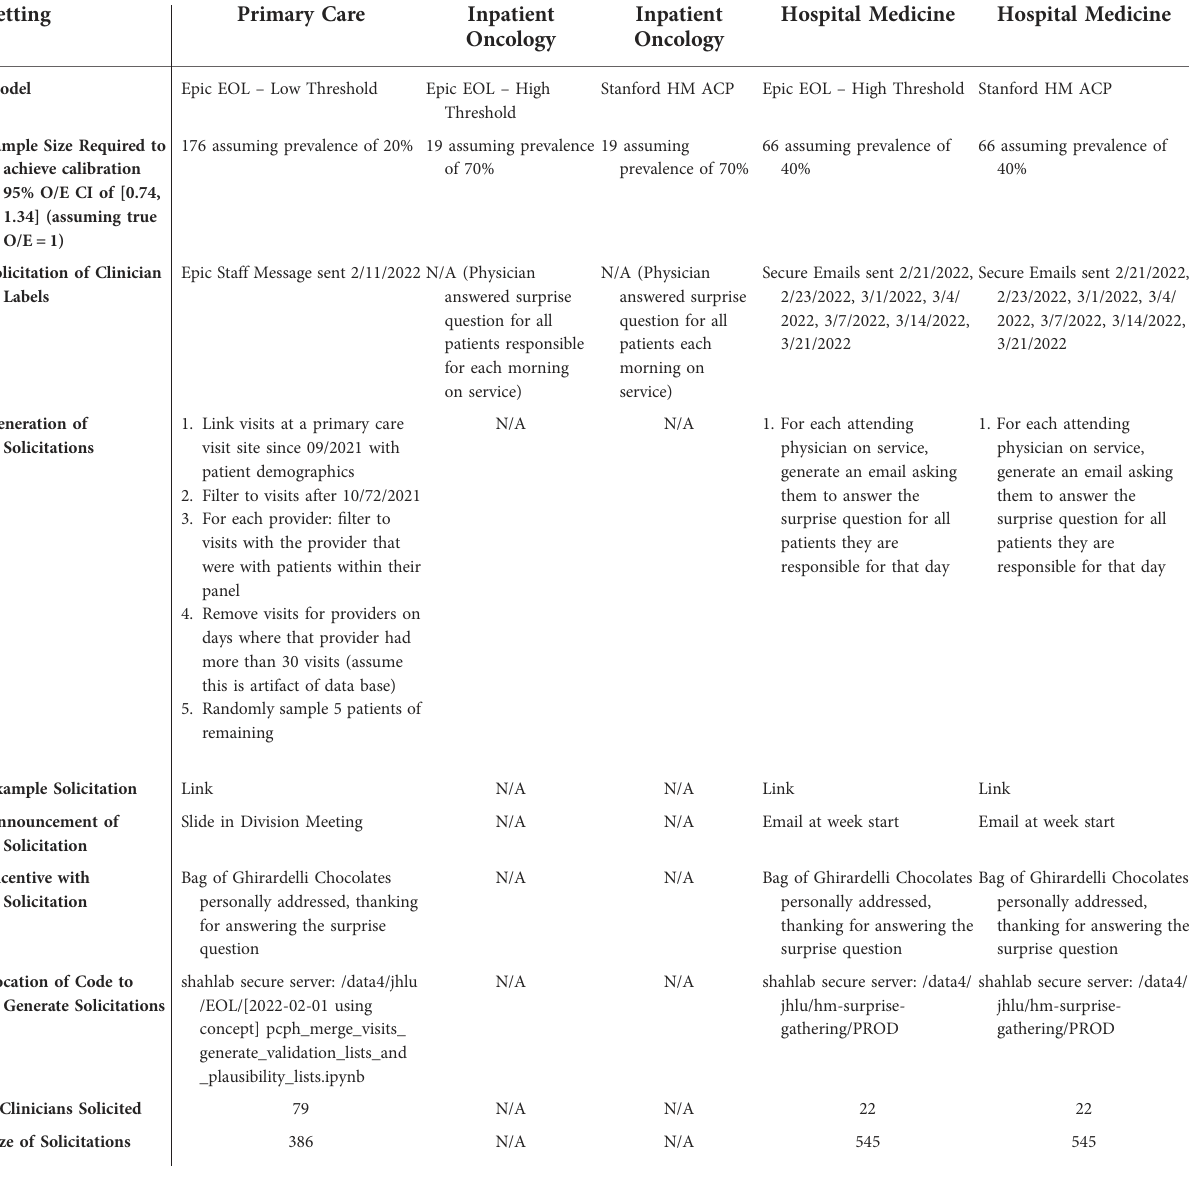
TABLE 3 Solicitation of clinician